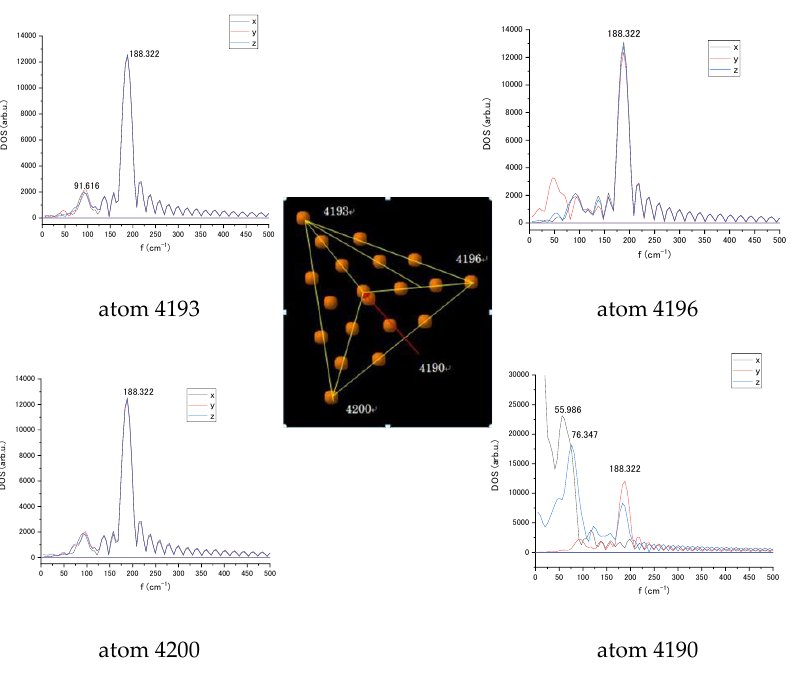
Figure 8. Vibrational spectra of the tip atoms of Au 20 nanoparticle numbered 4190, 4193, 4196, and 4200 in x, y , and z coordinates without interaction with the cytosine.